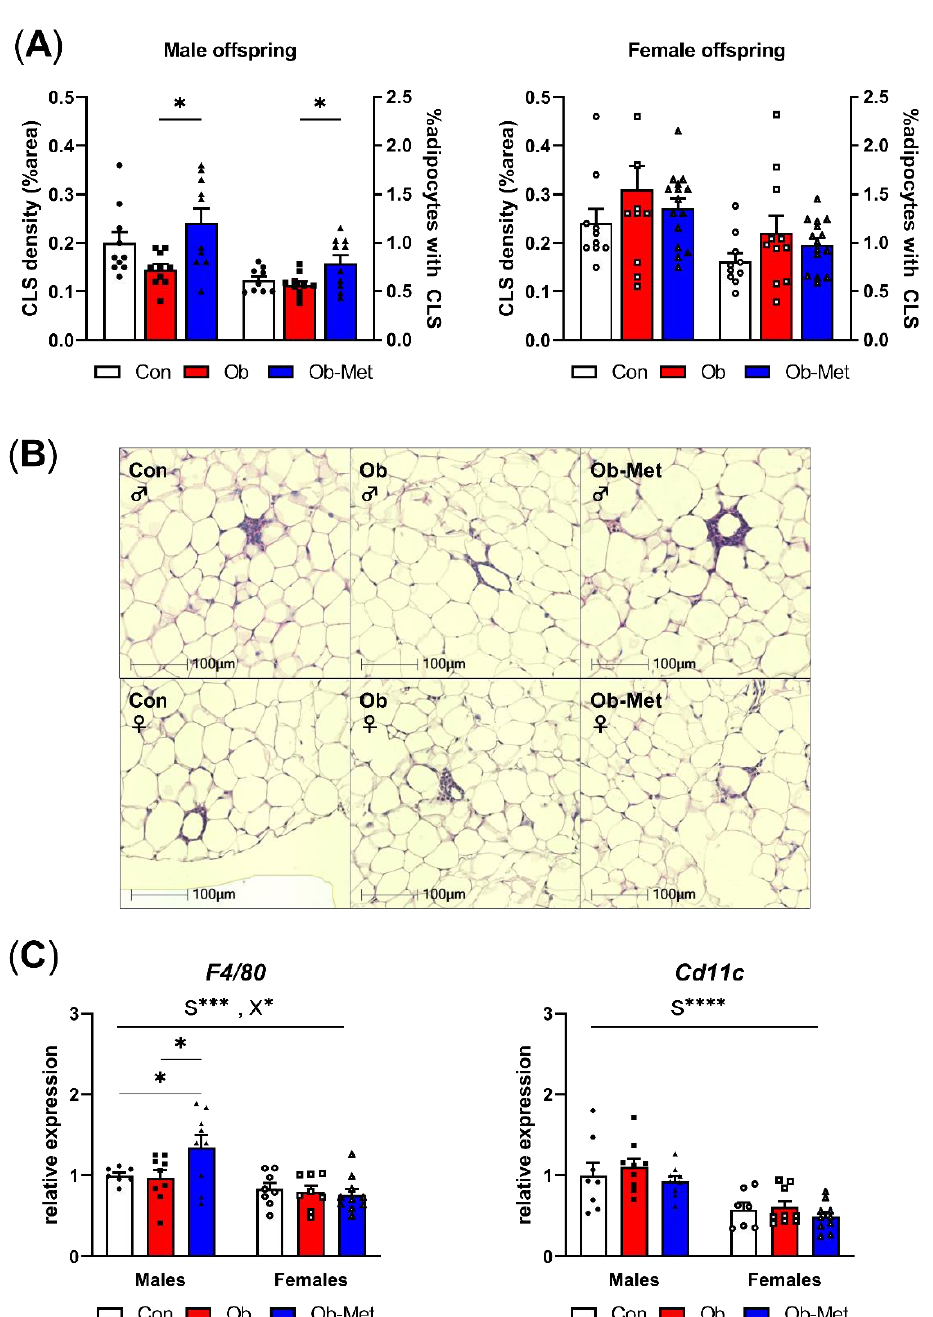
Figure 3. Inflammation in gonadal white adipose tissue. ( A ) Presence of crown-like structures (CLS) in gonadal white adipose tissue (WAT) of 8-week-old male (left) and female (right) offspring, expressed as percentage area of the WAT tissue and as the number of CLS divided by the number of adipocytes in the section (n = 10–15 independent litters per group). * p < 0.05 using one-way ANOVA with Tukey’s multiple comparison test. ( B ) Representative images of H&E-stained sections used for CLS analysis. ( C ) mRNA expression of macrophage markers in gonadal WAT relative to the expression of housekeeper gene Ppia and the male Con group (n = 7–10 independent litters per group). * p < 0.05, *** p < 0.001, **** p < 0.0001 for the main effect of sex (S), interaction between sex and the maternal environment (X) or Tukey’s multiple comparison using two-way ANOVA. Outliers were excluded from ( A ) CLS density; female Con (Grubb’s method, outlier excluded value 0.46%), and ( A ) %adipocytes with CLS; male Con (Grubb’s method, outlier excluded value 1.19%). From ( C ) F4/80 , two data points were excluded due to pipetting errors (male Con and female Ob). From ( C ) Cd11c , one data point was excluded due to pipetting errors (female